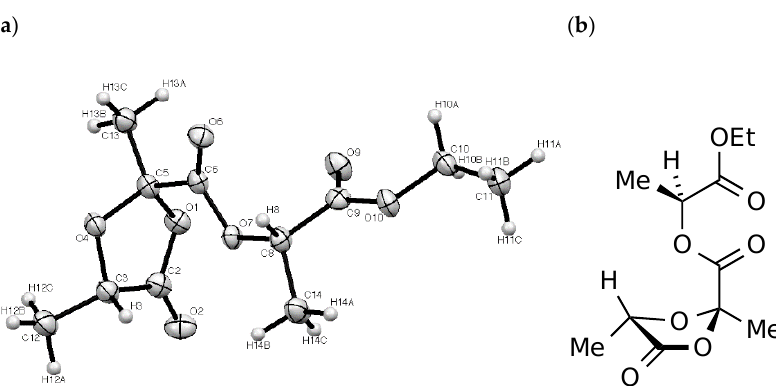
Figure 3. The molecular structure of 2 ( a ) with numbering scheme and anisotropic displacement ellipsoids drawn at the 50% probability level and ( b ) redrawn to show ring conformation.